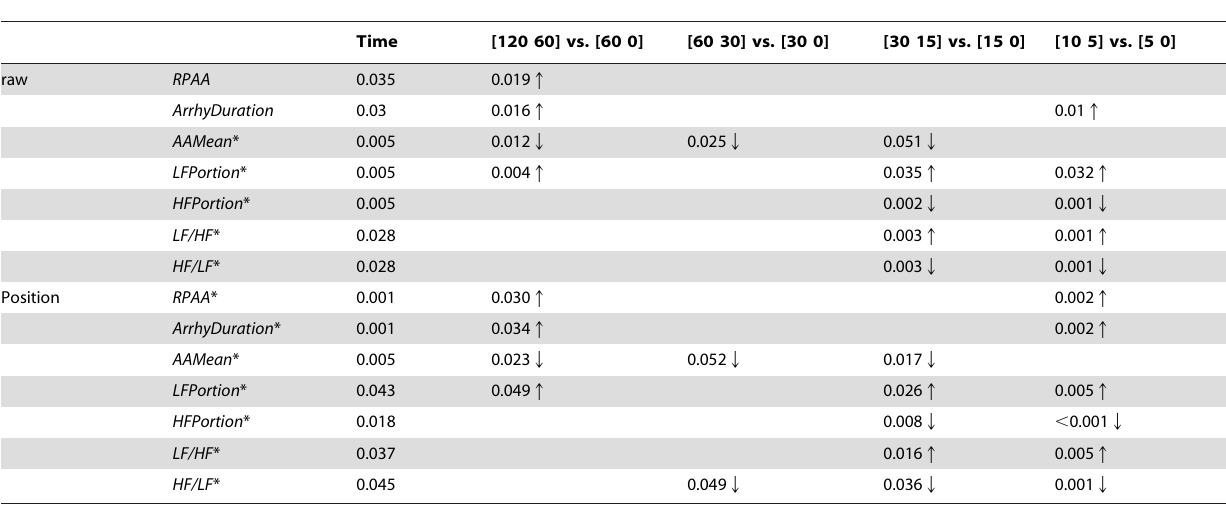
The upward and downward arrows stand respectively for the increasing and decreasing trend from one period to the next. ‘‘Time’’ column is the time effect significance in the two hours ANOVA analysis. The contrast analysis over the two time periods is listed subsequently. ‘‘0’’ is corresponding to the onset of AF. Variables with asterisk were log transformed.